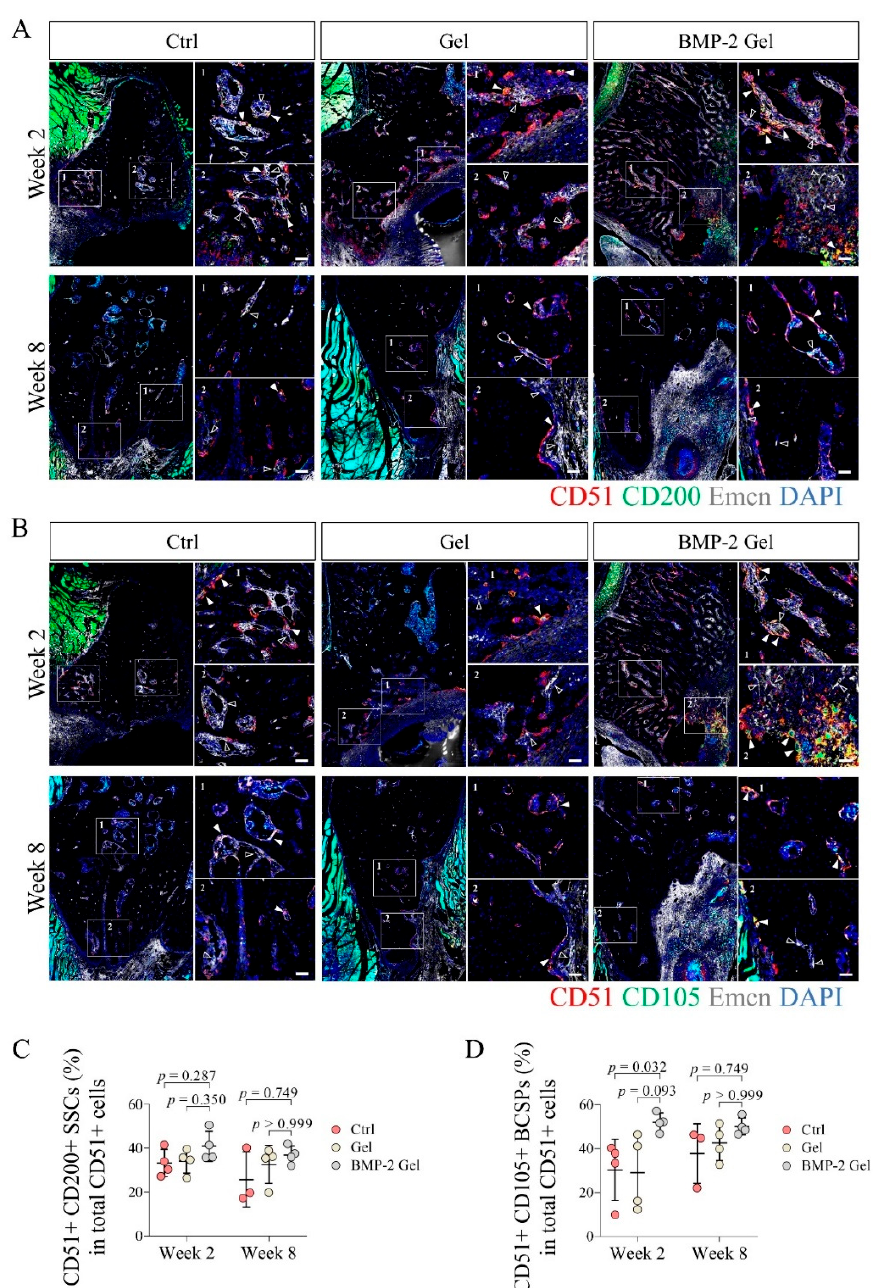
Figure 6. The fraction of CD51+ CD105+ SSCs descendants was elevated after implantation of BMP-2-loaded hydrogel in the newly regenerated bone. ( A , C ) Representative images and quanti- tative analysis of immunofluorescent staining of CD51+ CD200+ SSCs in the new bone. Scale bar, 50 µ m. The white arrow indicates the CD51+ CD200+ SSCs. The hollow arrow indicates the vessels. ( B , D ) Representative images and quantitative analysis of immunofluorescent staining of CD51+ CD105+ SSCs descendants in the new bone. Scale bar, 50 µ m. The white arrow indicates the CD51+ CD105+ SSCs descendants. The hollow arrow indicates the vessels. The p value was calculated by one-way ANOVA and Dunn’s multiple comparisons